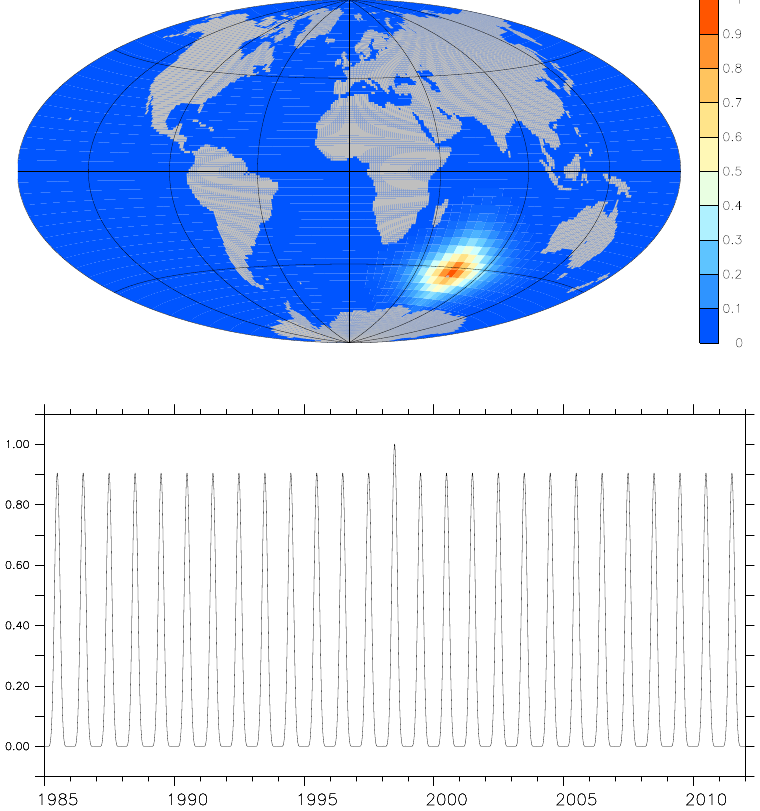
Fig. A1. Top: map of a-priori correlation coefficients with respect to an example pixel at (70 ◦ E, 49 ◦ S), illustrating how inverse adjustments to f DIC de-correlate with distance. Bottom: a-priori correlation coefficients with respect to an example time step in the middle of the int inversion period; in addition to the de-correlation away from the example time step, correlations rise again each year due to the dominance of the seasonal cycle.